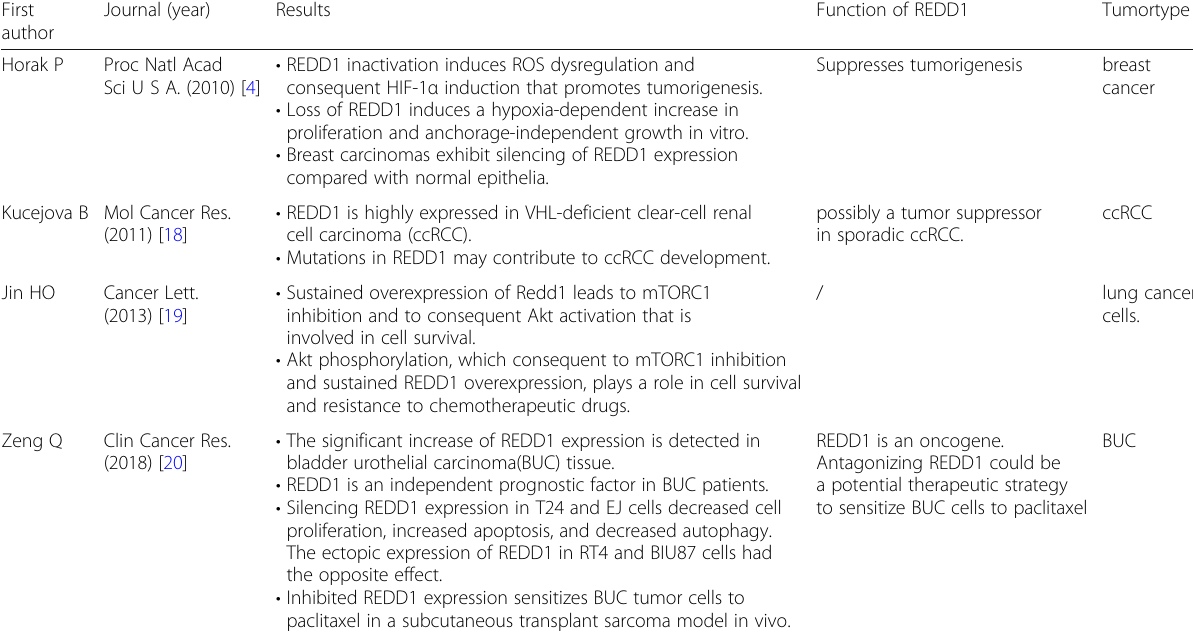
Table 8 Research of REDD1 in different tumor